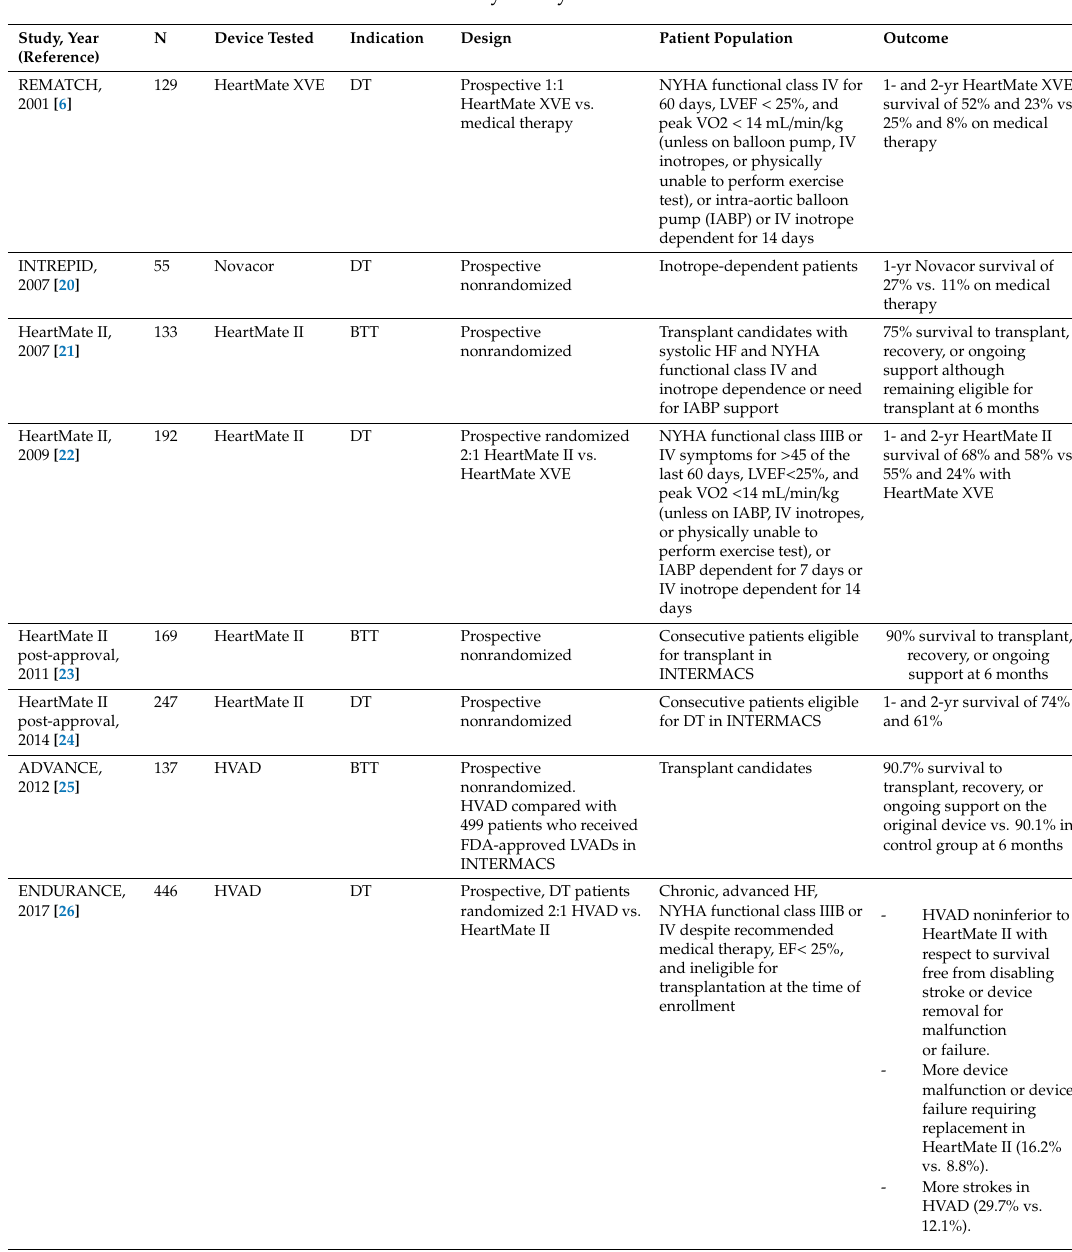
Table 3. Summary of key LVAD clinical